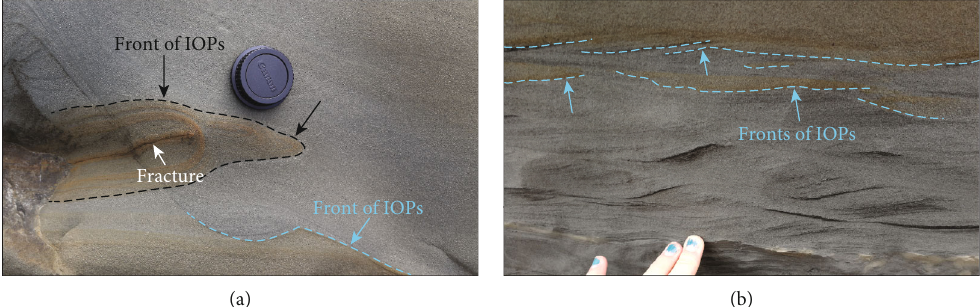
Figure 3: (a) Example of how a fracture (white arrow) can control the formation and extent of iron oxide precipitates (black, dashed line) and how depositional architecture (blue arrow) may control the fl ow of oxidizing fl uids (blue, dashed line); Hokianga, New Zealand. (b) Another example of how depositional architecture, here in the form of crossbedding, can control the extent of iron oxide precipitates; Taranaki, New